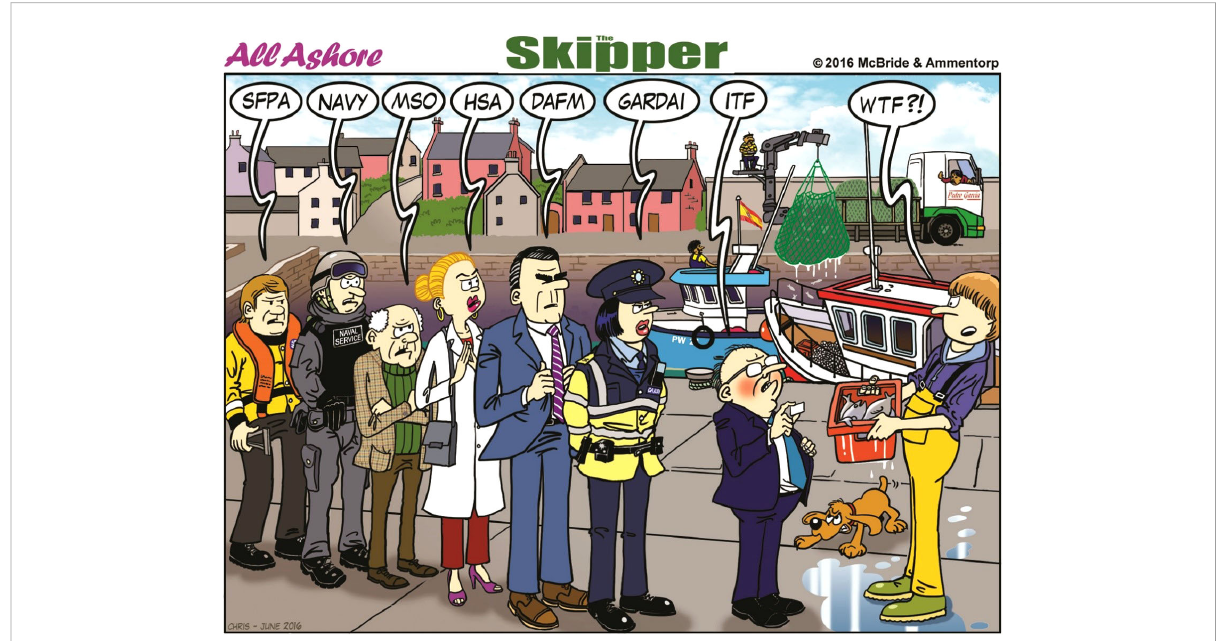
FIGURE 1 Cartoon taken from The Skipper, a leading journal for the Irish and UK fi shing industries, re fl ecting industry confusion over the number of different agencies they are required to interact with. (Image provided courtesy of The Skipper -